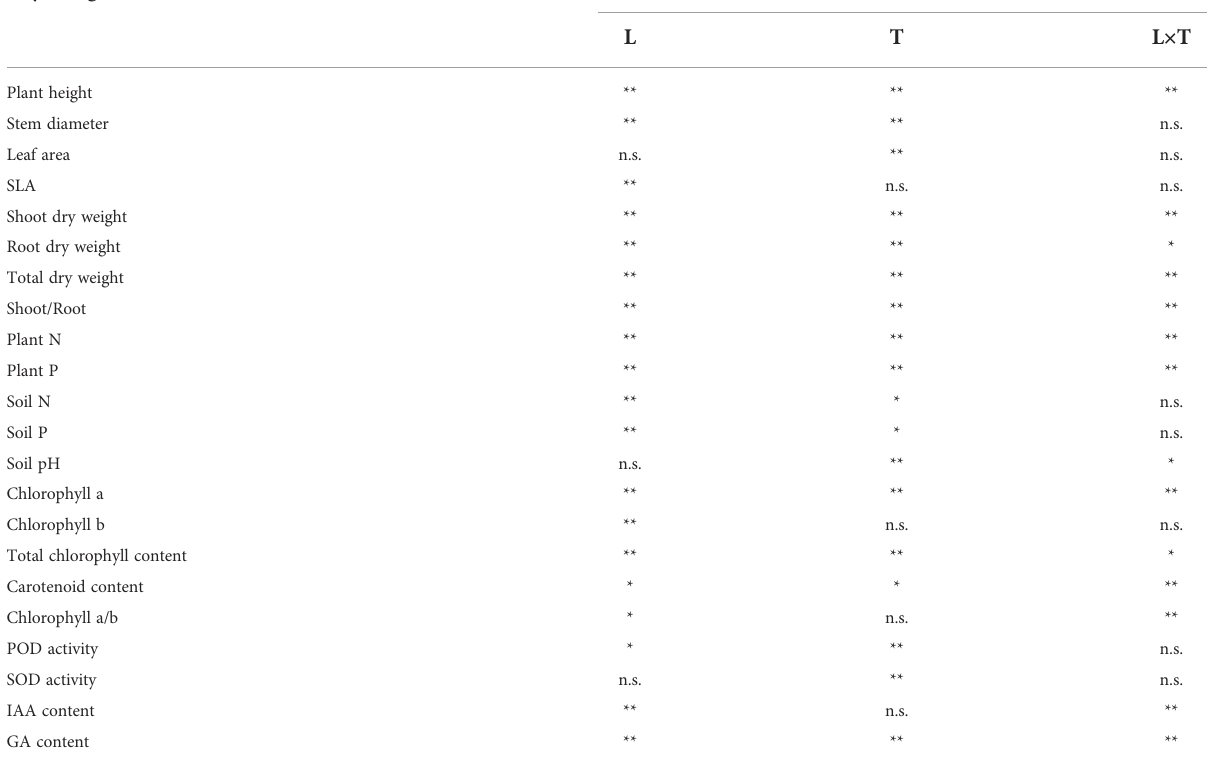
TABLE 2 Two-way analysis of variance indicating the interactive effects of independent variables (light supply and Trichoderma inoculation treatment) and their co-in fl uence on dependent variables. Physiological